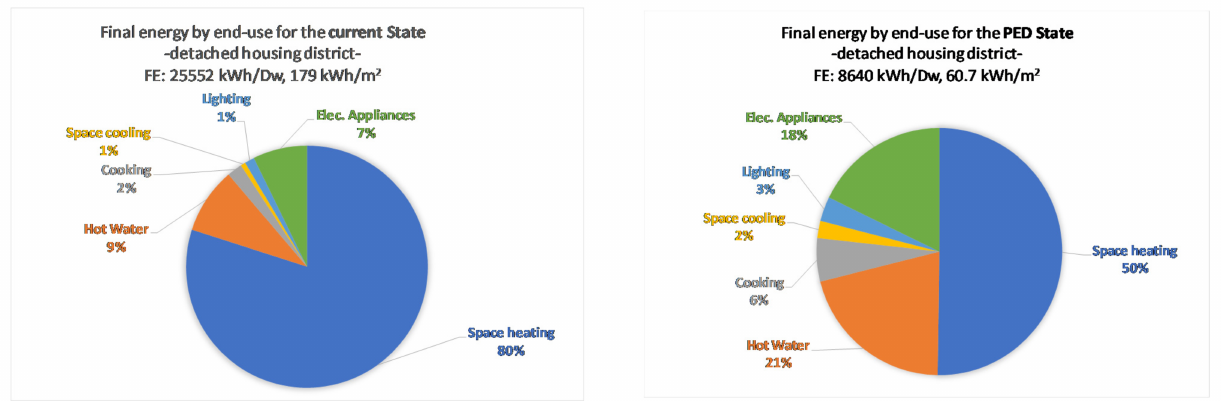
Figure 4. Distribution of final energy demand by end-use activities for the expected PED, compared to the current state for the considered detached housing district (source: